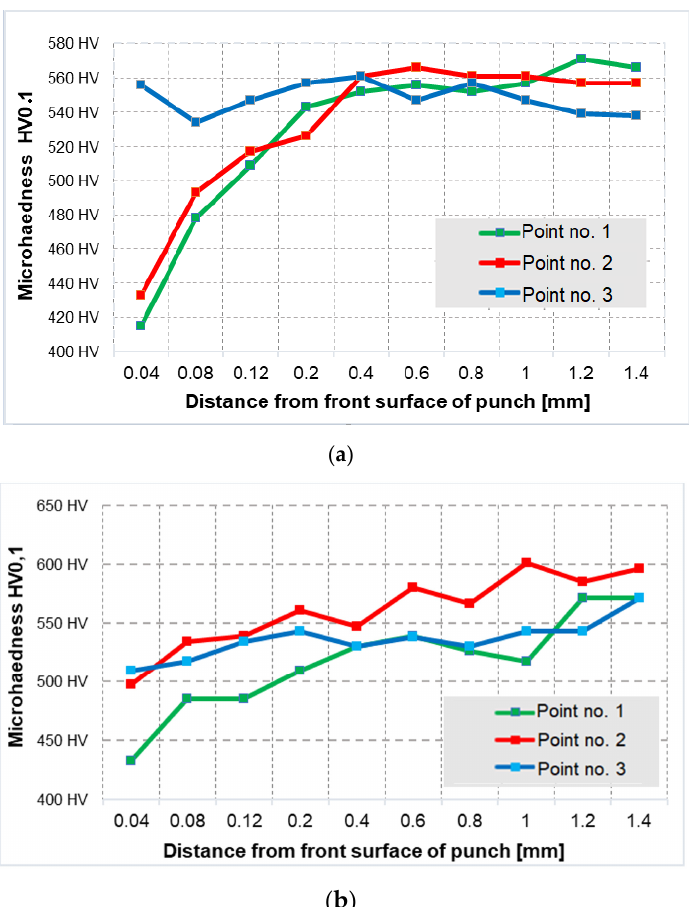
Figure 13. Course of hardness for the selected two representative punch groups ( a ) punch after 700 items, ( b ) punch after 3000 items.